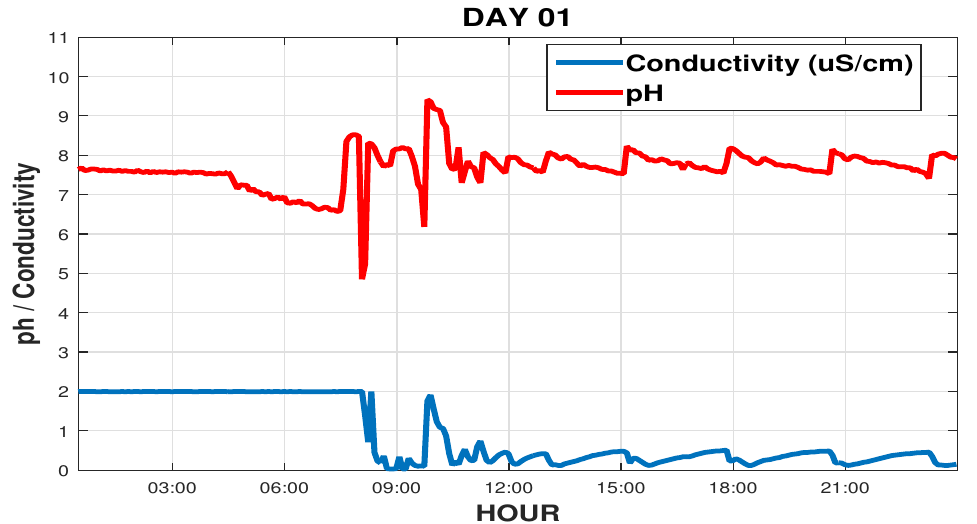
Figure 16. pH readings and RO conductivity during one day of intervention.